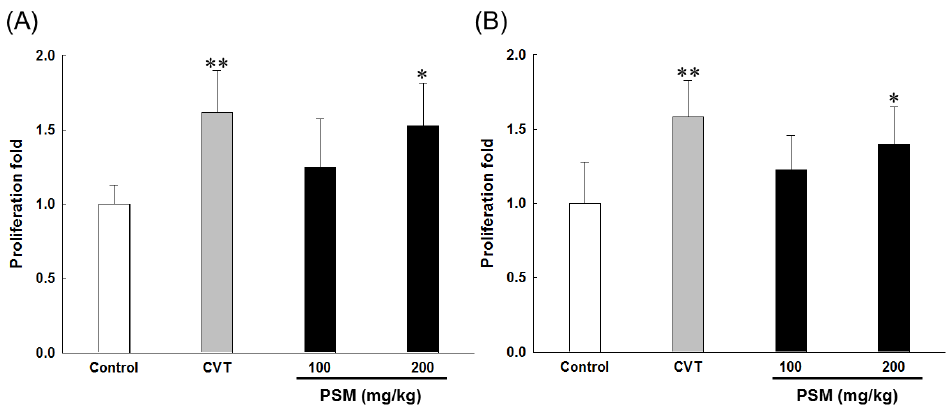
Figure 1. The effects of PSM on lymphocyte proliferation in normal mice. The effects of PSM on ( A ) ConA-induced T-lymphocyte or ( B ) LPS-induced B-lymphocyte proliferation. CVT: CVT-E200™ (200 mg/kg) was used as a positive control. Cell proliferation was measured by the MTT assay. The data are expressed as the mean ± SD ( n = 10). * p < 0.05, ** p < 0.01 vs. vehicle-treated control group.